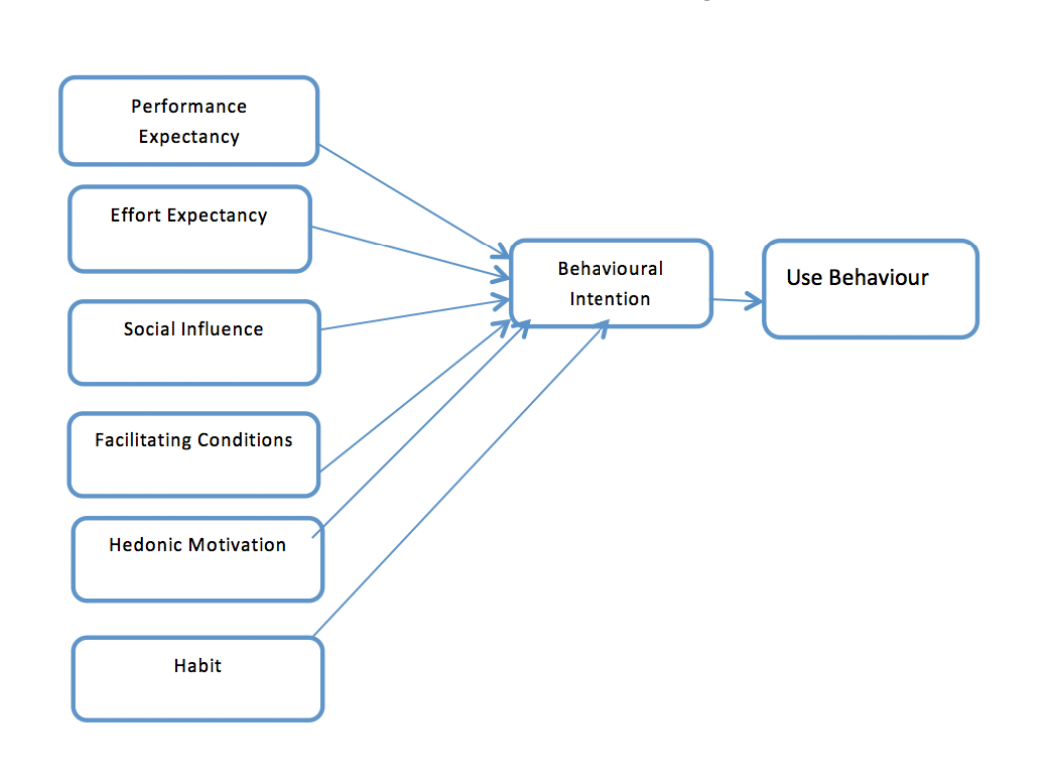
Figure 2 . Research